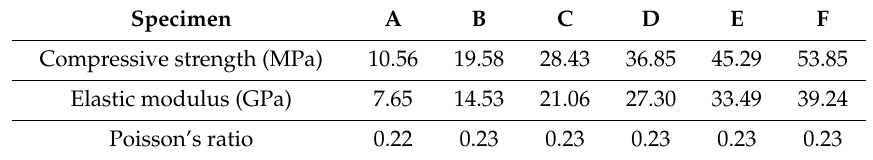
Figure 7. Influence of mortar attribution on compressive behaviors of ordinary concrete. Table 5. The ordinary concrete specimens’ mechanical properties.